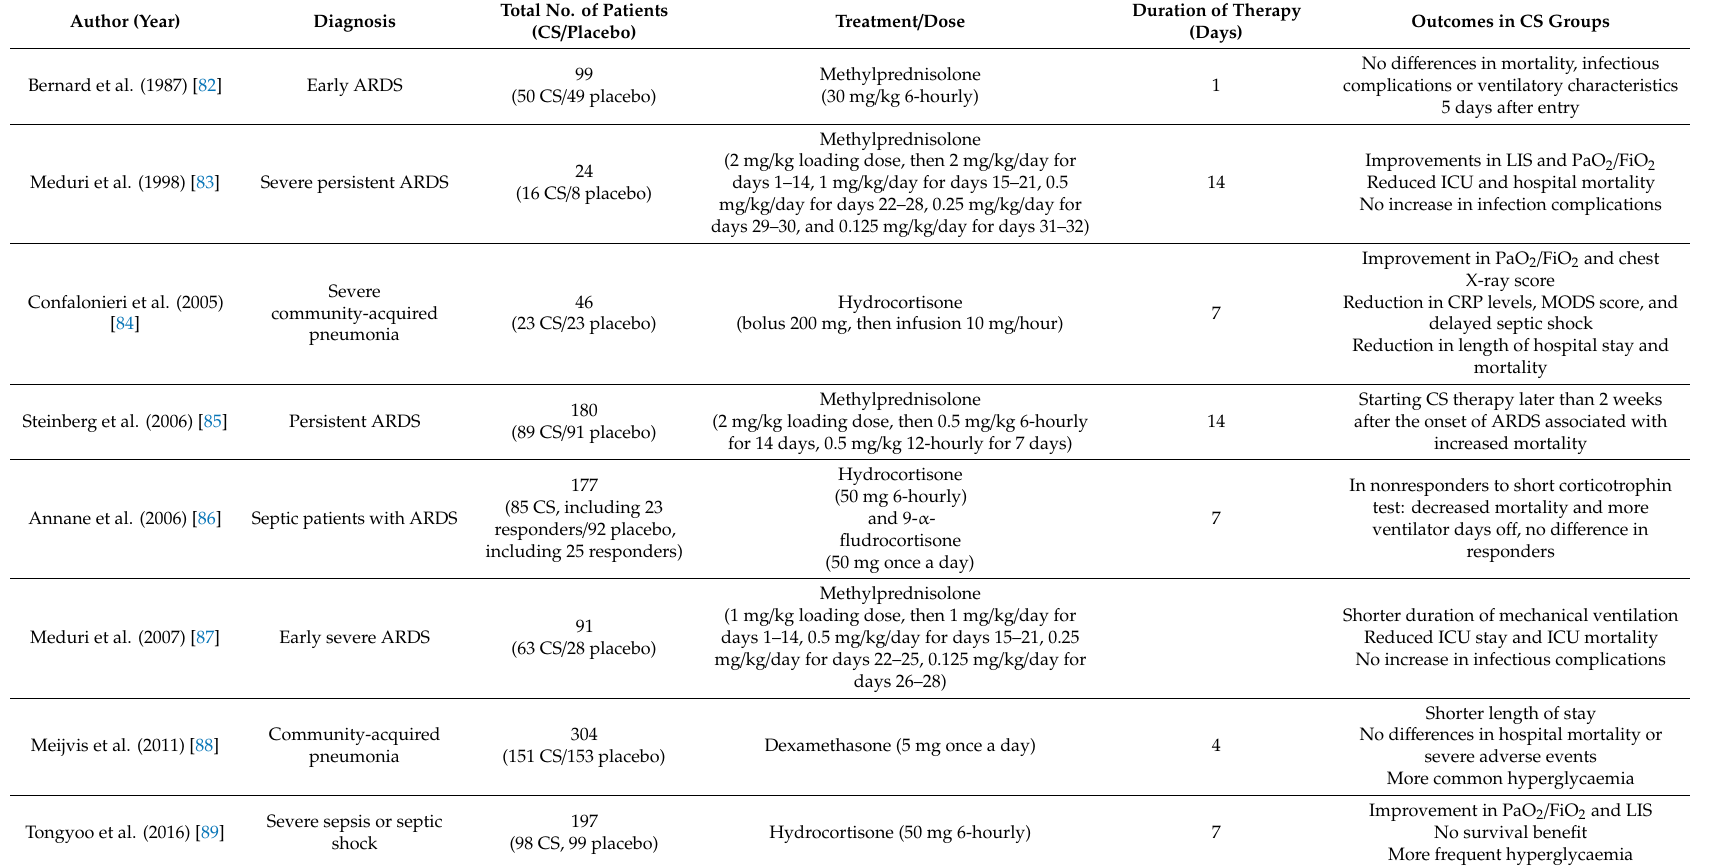
Table 1. Randomized controlled trials of CS in adult patients with ARDS or